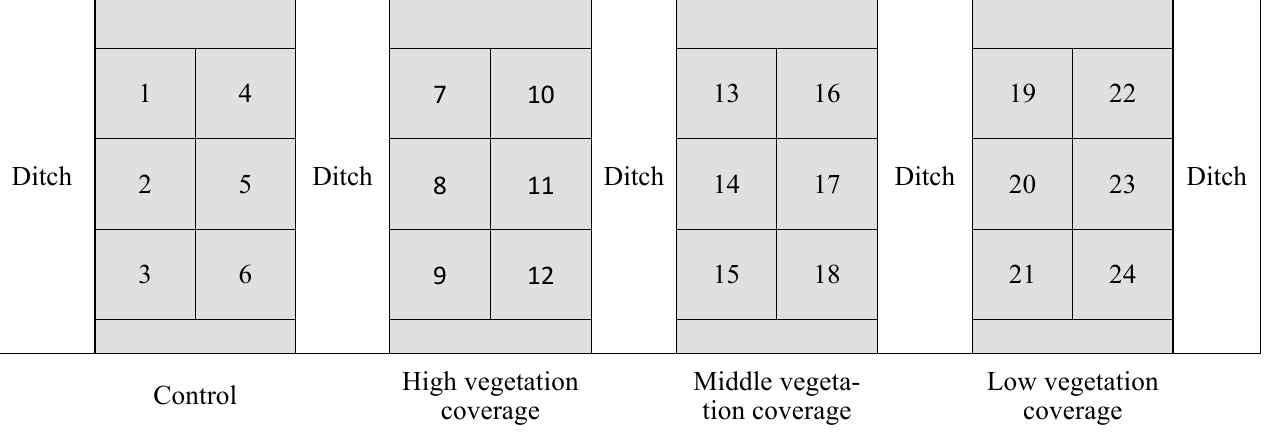
Fig 1 . Schematic diagram about experimental